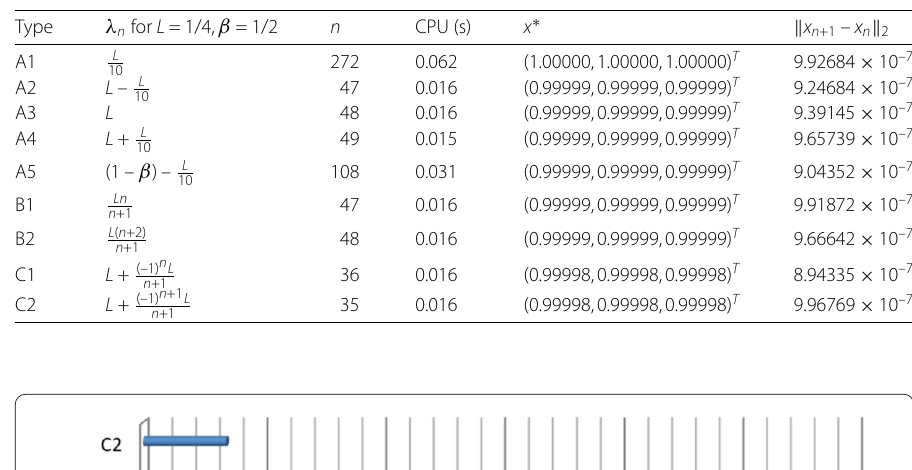
Table 2 Numerical results of Example 4.5 for the initial points x 0 = (1,–1,–1) T and x 1 = (–1,0,1) T using the algorithm in Theorem 4.4